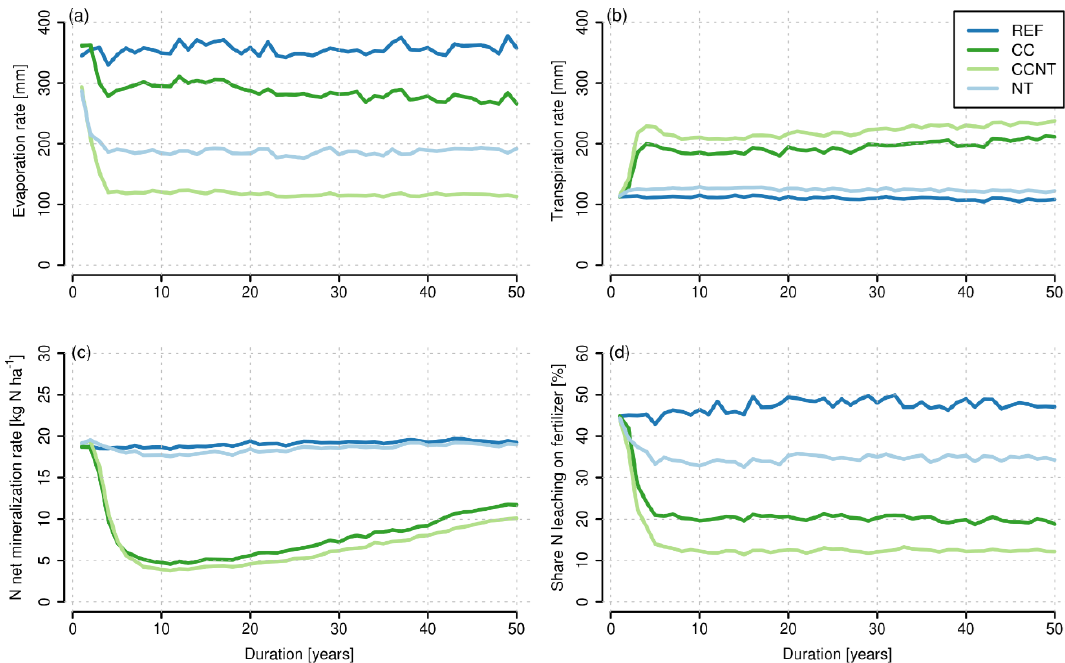
Figure 2. Plots in panel display the time series for the 50-year simulation period of the annual global spatially aggregated area-weighted median per hectare cropland ( ∼ 1500 × 10 6 ha) as lines per management scenario (REF: dark blue; CC: dark green; CCNT: light green; NT: light blue) for (a) evaporation rate in millimeters, (b) transpiration rate in millimeters, (c) soil N net-mineralization rate in kgNha − 1 (derived as absolute difference between soil gross N mineralization and immobilization rates), and (d) shares of annual soil N loss through leaching of applied mineral N fertilizer rate in percent